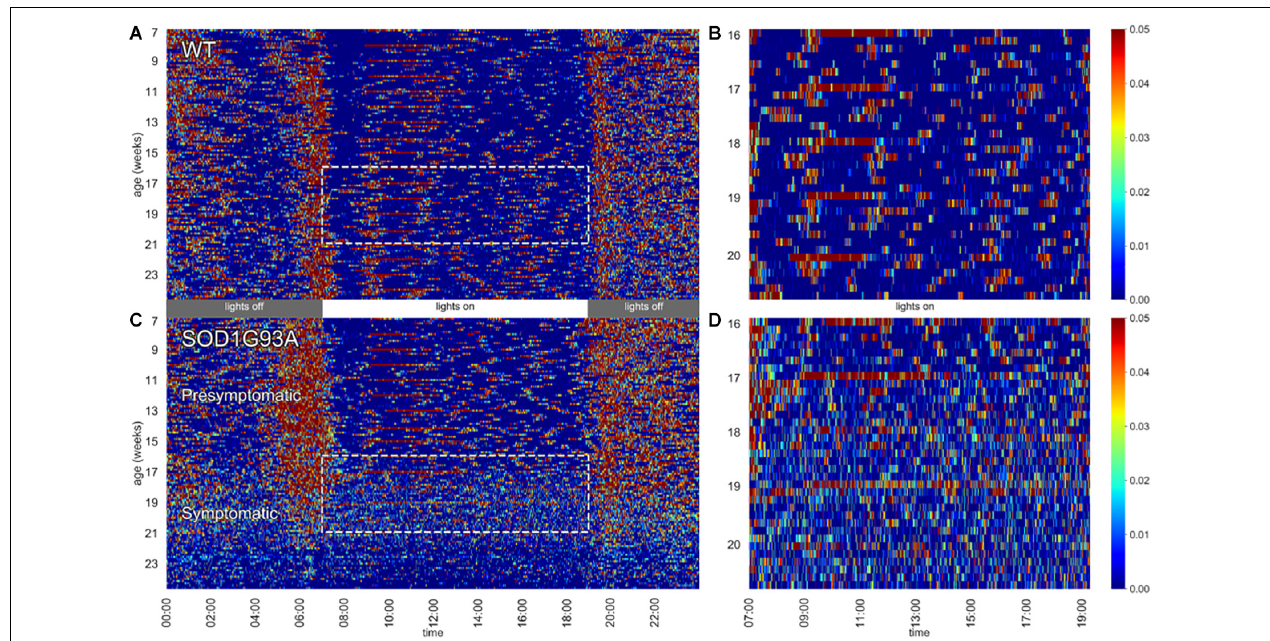
FIGURE 1 | Heat maps of activity. Left panels depict 24 h activity across 7–24 weeks of age in a cage of WT (A) and a cage of SOD1G93A (C) male mice ( n = 2 per cage). Dotted boxes represent activity during day time between age 16–20 weeks, which are then zoomed in the respective right panels (B,D) . Weekly cage change related peaks of activity appear clearly as red